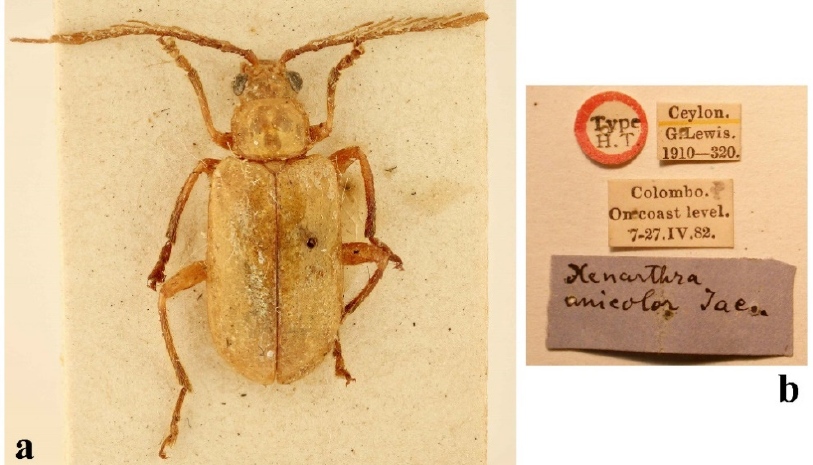
Figure 9. Taumacera unicolor (Jacoby, 1887): ( a ) holotype, male; ( b ) labels. (Not to scale).